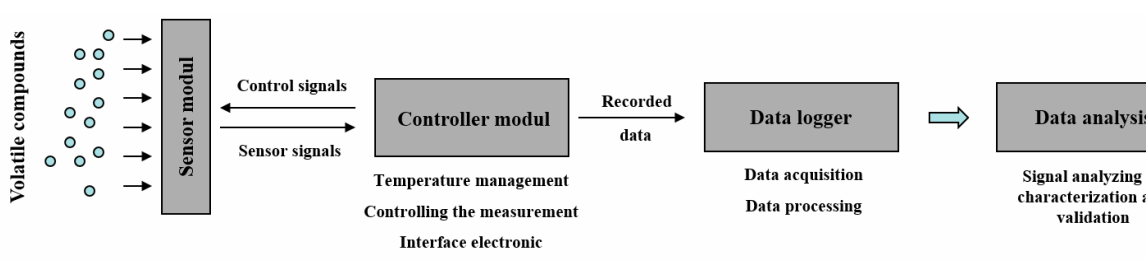
Figure 1. Configuration of the used electronic nose